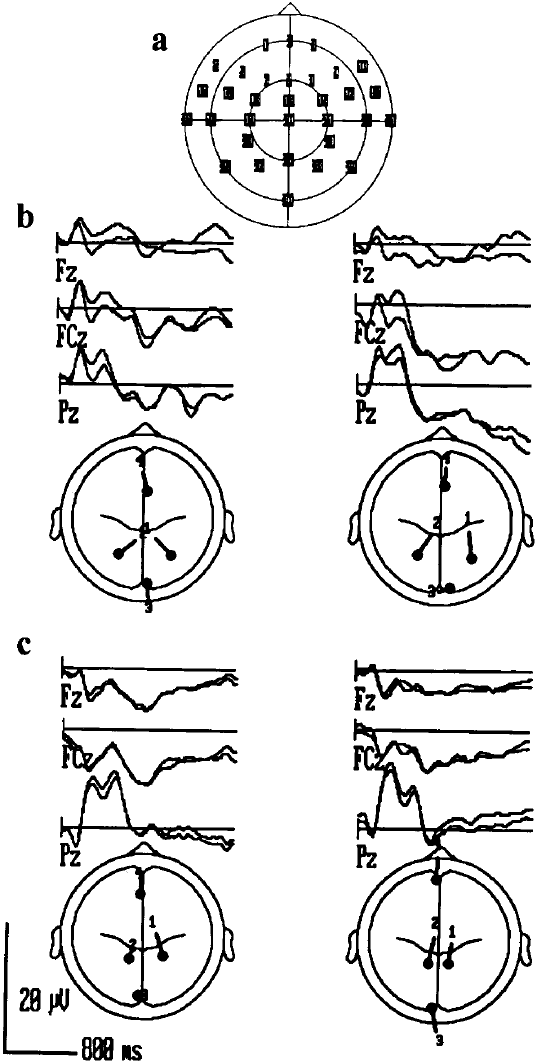
Fig. 2. A schema showing the electrode placement on the scalp in a . CNVs associated with the visual pattern and place recognition tasks in b and c . The examples of recorded waveforms and the waveforms created by the models for the same locations are superimposed and in addition, the respective 4-dipole models are viewed from the top of the head in two individual subjects. Visual pattern recognition CNVandplacerecognitionCNVforonesubjectin b andforanother subject pattern recognition CNV and place recognition CNV in c . Note that the dipole 4 in the frontal region appears more anterior in the models explaining the place recognition tasks (models on the